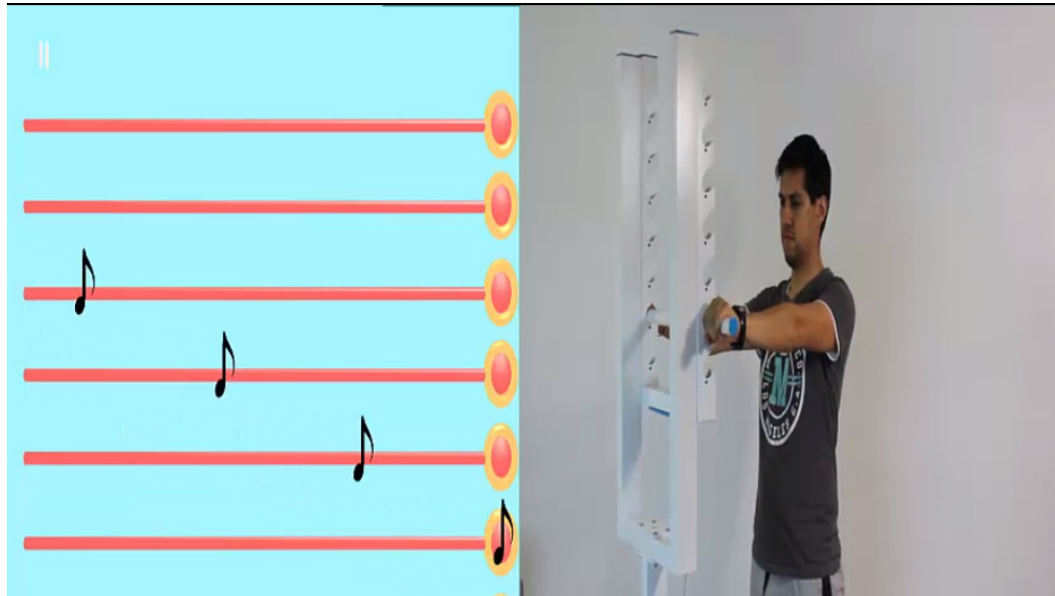
Figure 3. Left: Serious video game screenshot. Right: User using the ladder technological device.